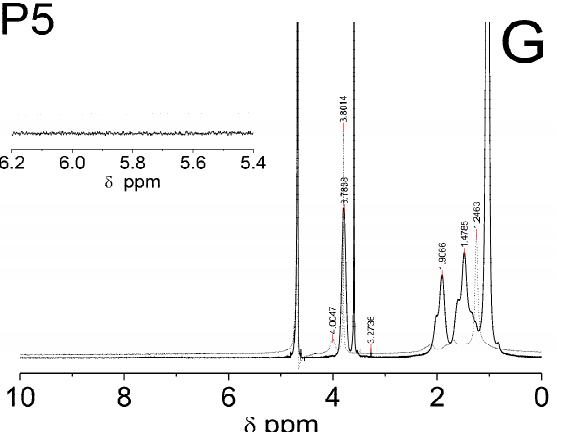
Figure 6. 1 H NMR spectra of monomer NIPA ( A ), co-polymers PEGMEM ( B ), and synthesized polymers P1 ( C ), P2 ( D ), P3 ( E ), P4 ( F ), and P5 ( G ) which were swollen in D 2 O and recorded at 25 ◦ C (solid line) and 42 ◦ C (dashed line). The enlarged areas in the 1 H NMR spectra present the resonance range of the vinyl protons.